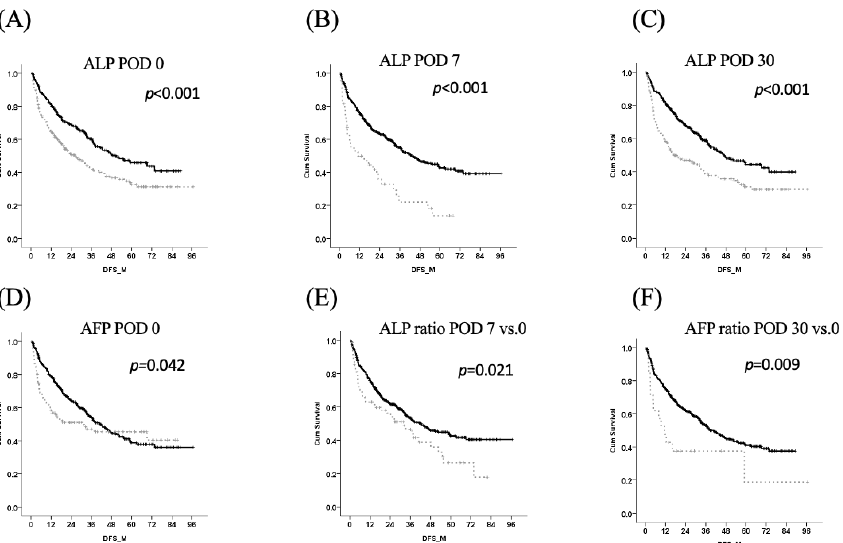
Figure 3. The analysis of recurrence-free survival. Kaplan–Meier survival curve for AFP and ALP in HCC in the perioperative period. ( A ), ( B ) and ( C ) Higher ALP in perioperative period at POD 0, 7 and 30 represented significant risk for HCC recurrence ( p < 0.001). ( D ) AFP more than 200 ng/mL is a risk factor for recurrence, too. ( E ) and ( F ) ALP ratio > 1.46 (POD 7 vs. POD 0) and AFP ratio (POD 30 vs. POD 0) > 1.519 were independent factors for recurrence-free survival. Abbreviations: alkaline phosphatase (ALP) and α -fetoprotein (AFP).